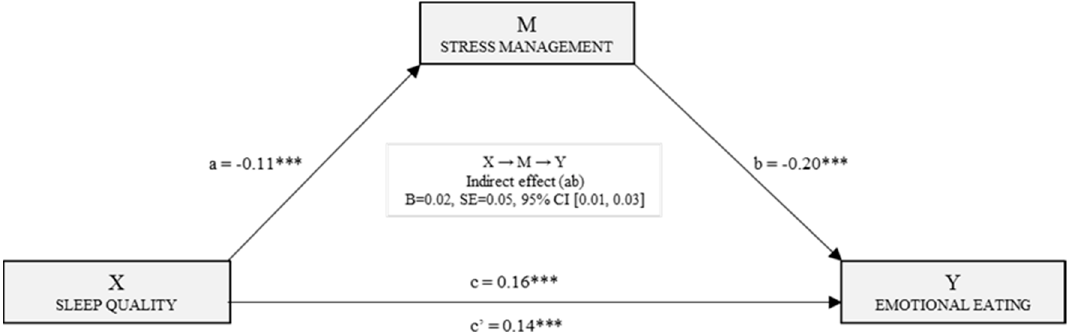
Figure 4. Simple mediation model of stress management in the relationship between sleep quality and emotional eating. Note. *** p < 0.001.